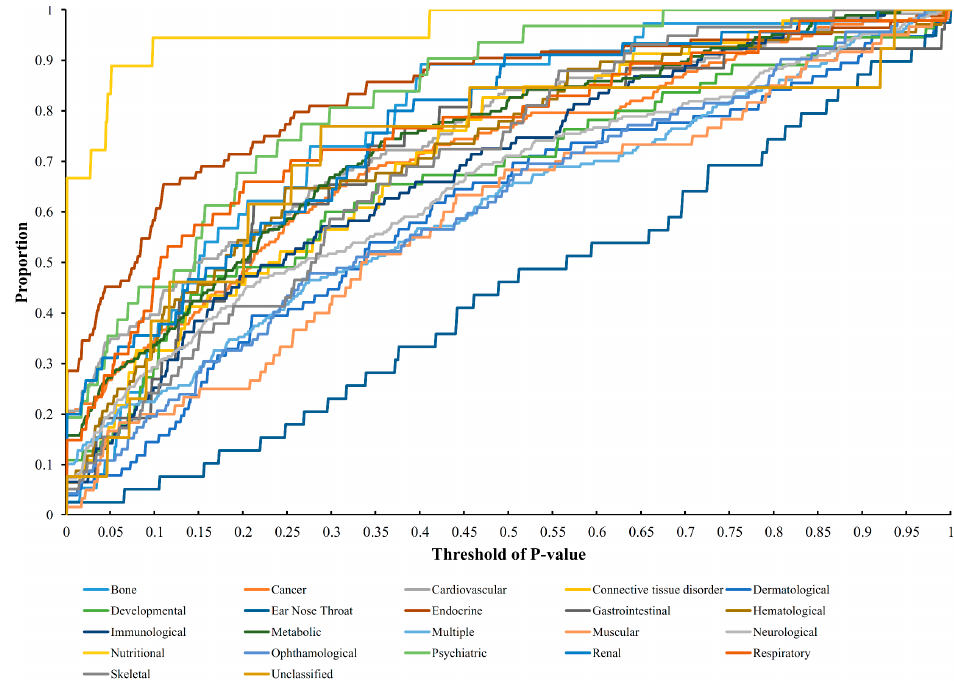
Figure 2. Proportion–threshold (PT) curves for 22 disease classes. X-axis represents the threshold of p -value (cf. Equation (3)), and Y-axis denotes the proportion of disease genes receiving the p -values less than the threshold.